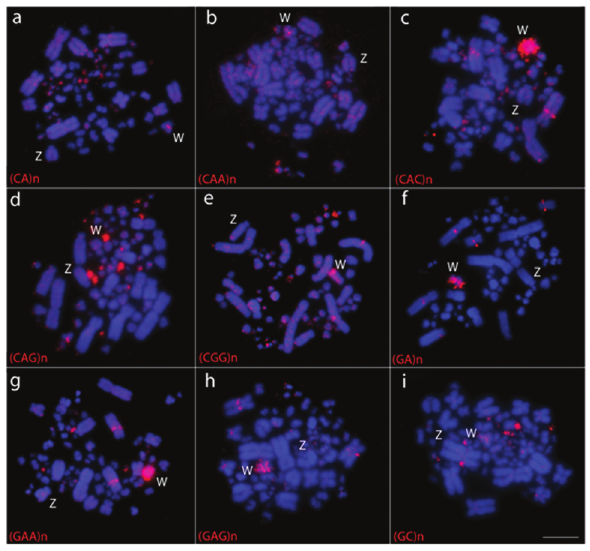
Figure 4 - Metaphases of a female Leptotila verreauxi in experiments of FISH using nine different microsatellite sequences (a-i). Chromosomes were counterstained with DAPI (blue) and probes were directly Cy3 (red) labeled. Microsatellite sequences are indicated on the bottom left of each figure. Sex chromosomes are indicated in each metaphase. Bar = 5 (cid:2)